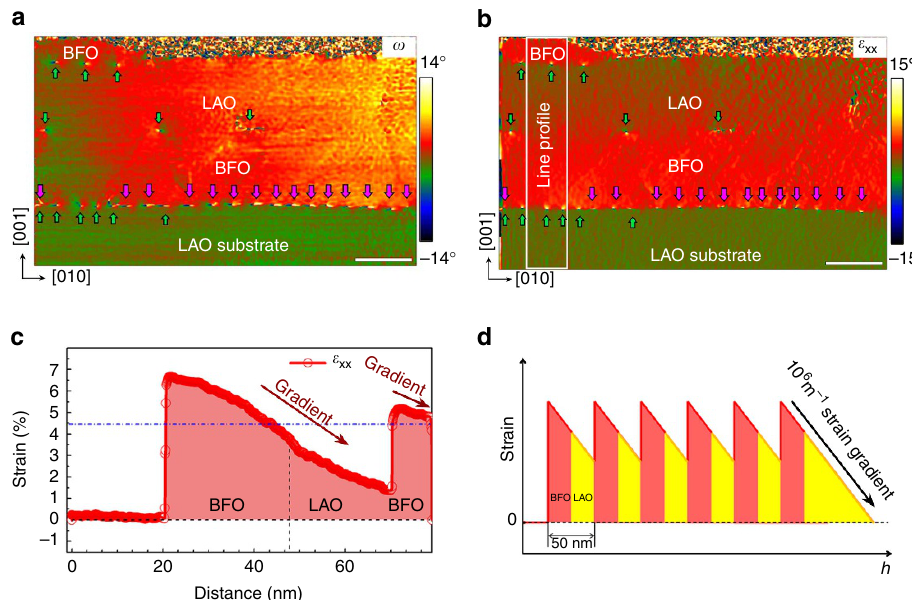
Figure 4 | Continuous strain gradient in the multilayered BiFeO 3 /LaAlO 3 /BiFeO 3 /LaAlO 3 (001) nanostructures. ( a ) 2D lattice rotation map ( o ), and ( b ) in-plane strain ( e xx ) map via GPA. Scale bars in a and b are 20nm. Note the continuous change of lattice rotation all over the BiFeO 3 /LaAlO 3 /BiFeO 3 multilayer nanostructure across the in-plane direction. A white boxed area labelled as line profile in b is chosen as a visualization line-profile as shown in c . The resultant continuous decrease of in-plane strain in the first LaAlO 3 /BiFeO 3 double-layer across the out-of-plane direction is remarkable. Note that except for the BiFeO 3 /LaAlO 3 (001) substrate interface, the two BiFeO 3 /LaAlO 3 interfaces are relaxed only by a [010] dislocations, thus the bending deformations transfer to each layer above the substrate, since there is no other a [001] components to relax the bending deformations. Note that giant strain gradient also transfers to the top BiFeO 3 layer. Thus the linear strain gradient can be patterned into potential device elements by simply a multilayer growth of various kinds of perovskite nanostructures, without concerns about the dimensions and mismatches. ( d ) A schematic illustration for the preservation of linear strain gradient in perovskite nanostructures through a multilayer strategy. This strategy allows a periodic recovering of in-plane strains which do not severely increase the elastic deformation of each BiFeO 3 /LaAlO 3